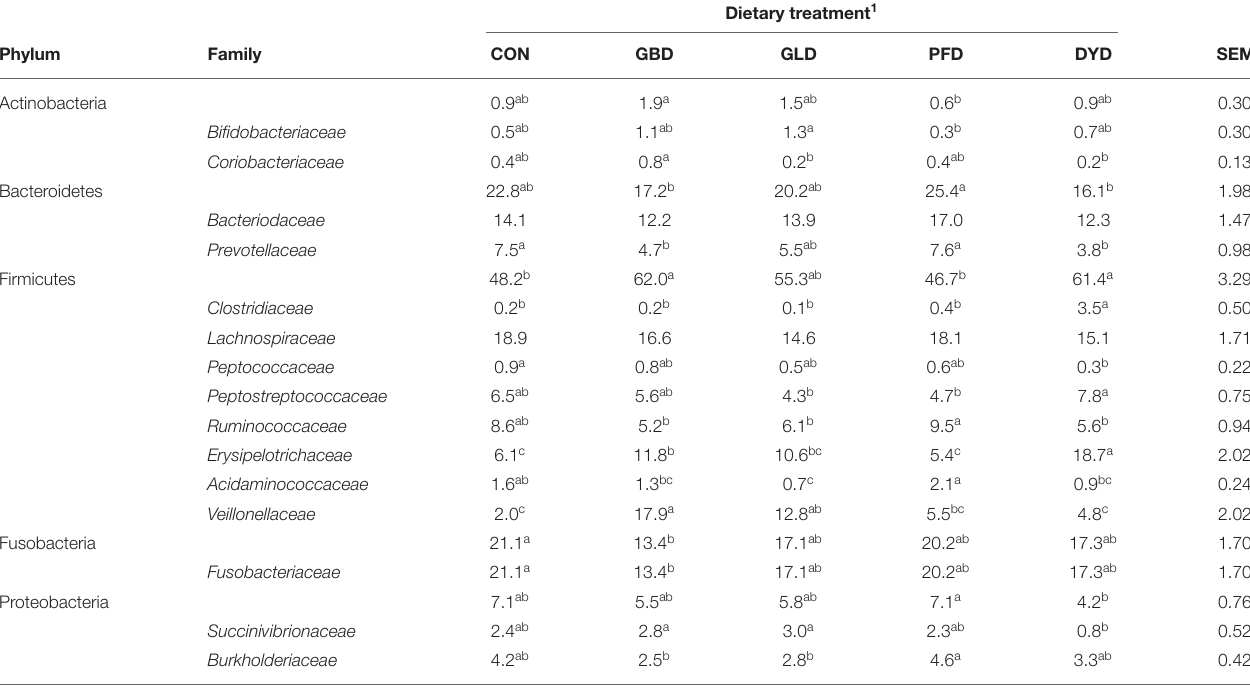
TABLE 8 | Relative abundance of bacterial phyla and families of dogs fed diets containing legumes or yeast as primary protein sources.